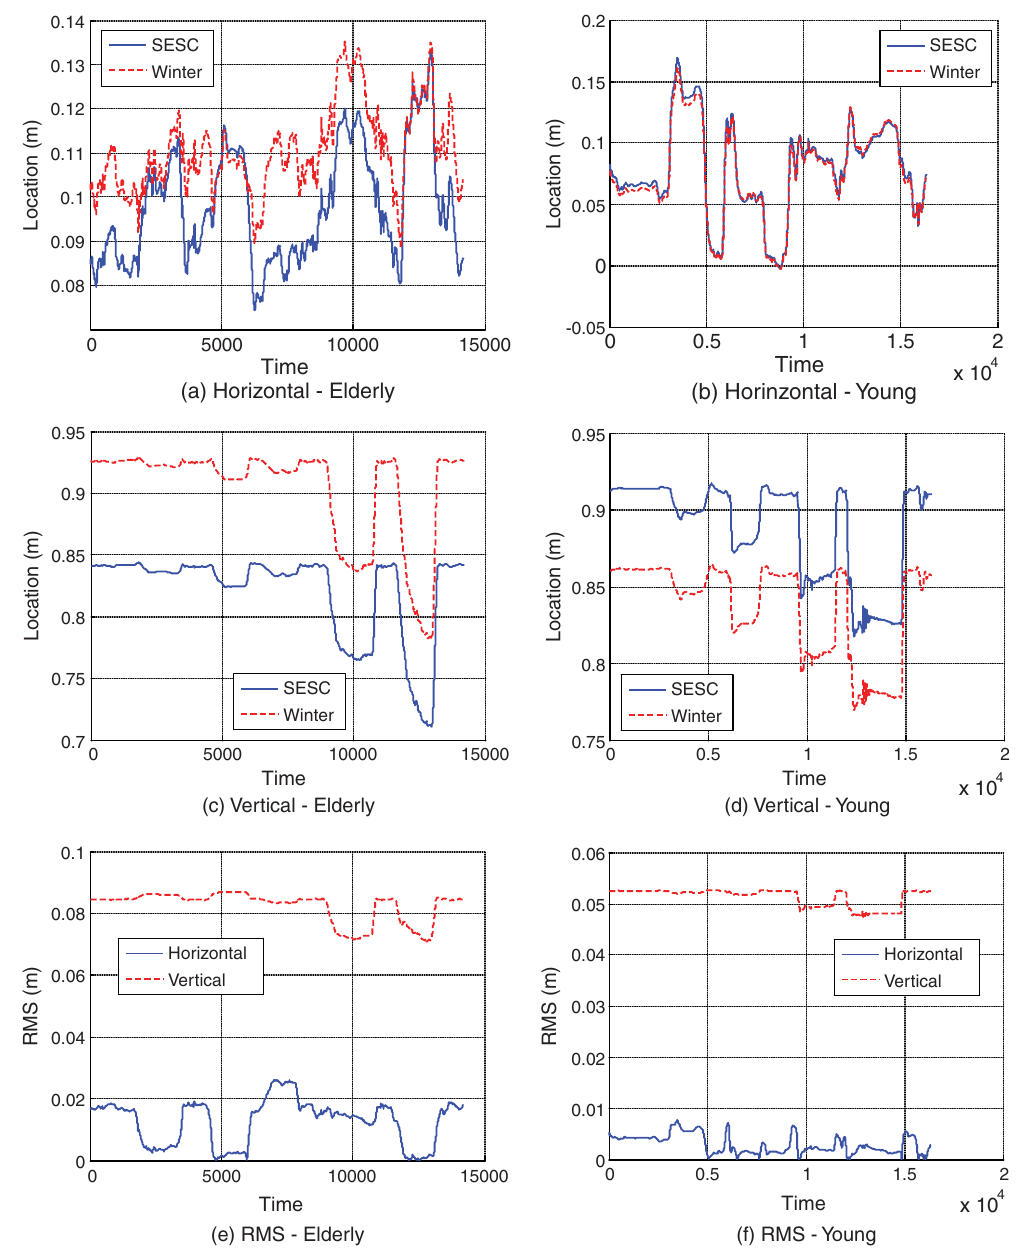
Fig.10. CoMEstimationofanelderlyandanyoungsubjectand,ExperimentResults:ComparisonoftheestimatedCoMwiththeCoMcomputed classicaly from anthropometric tables; (a) and (b) show the horizontal estimation of the CoM; (c) and (d) show the vertical estimation of the CoM; (e) and (f) show the RMS of the difference between the two estimation methods.